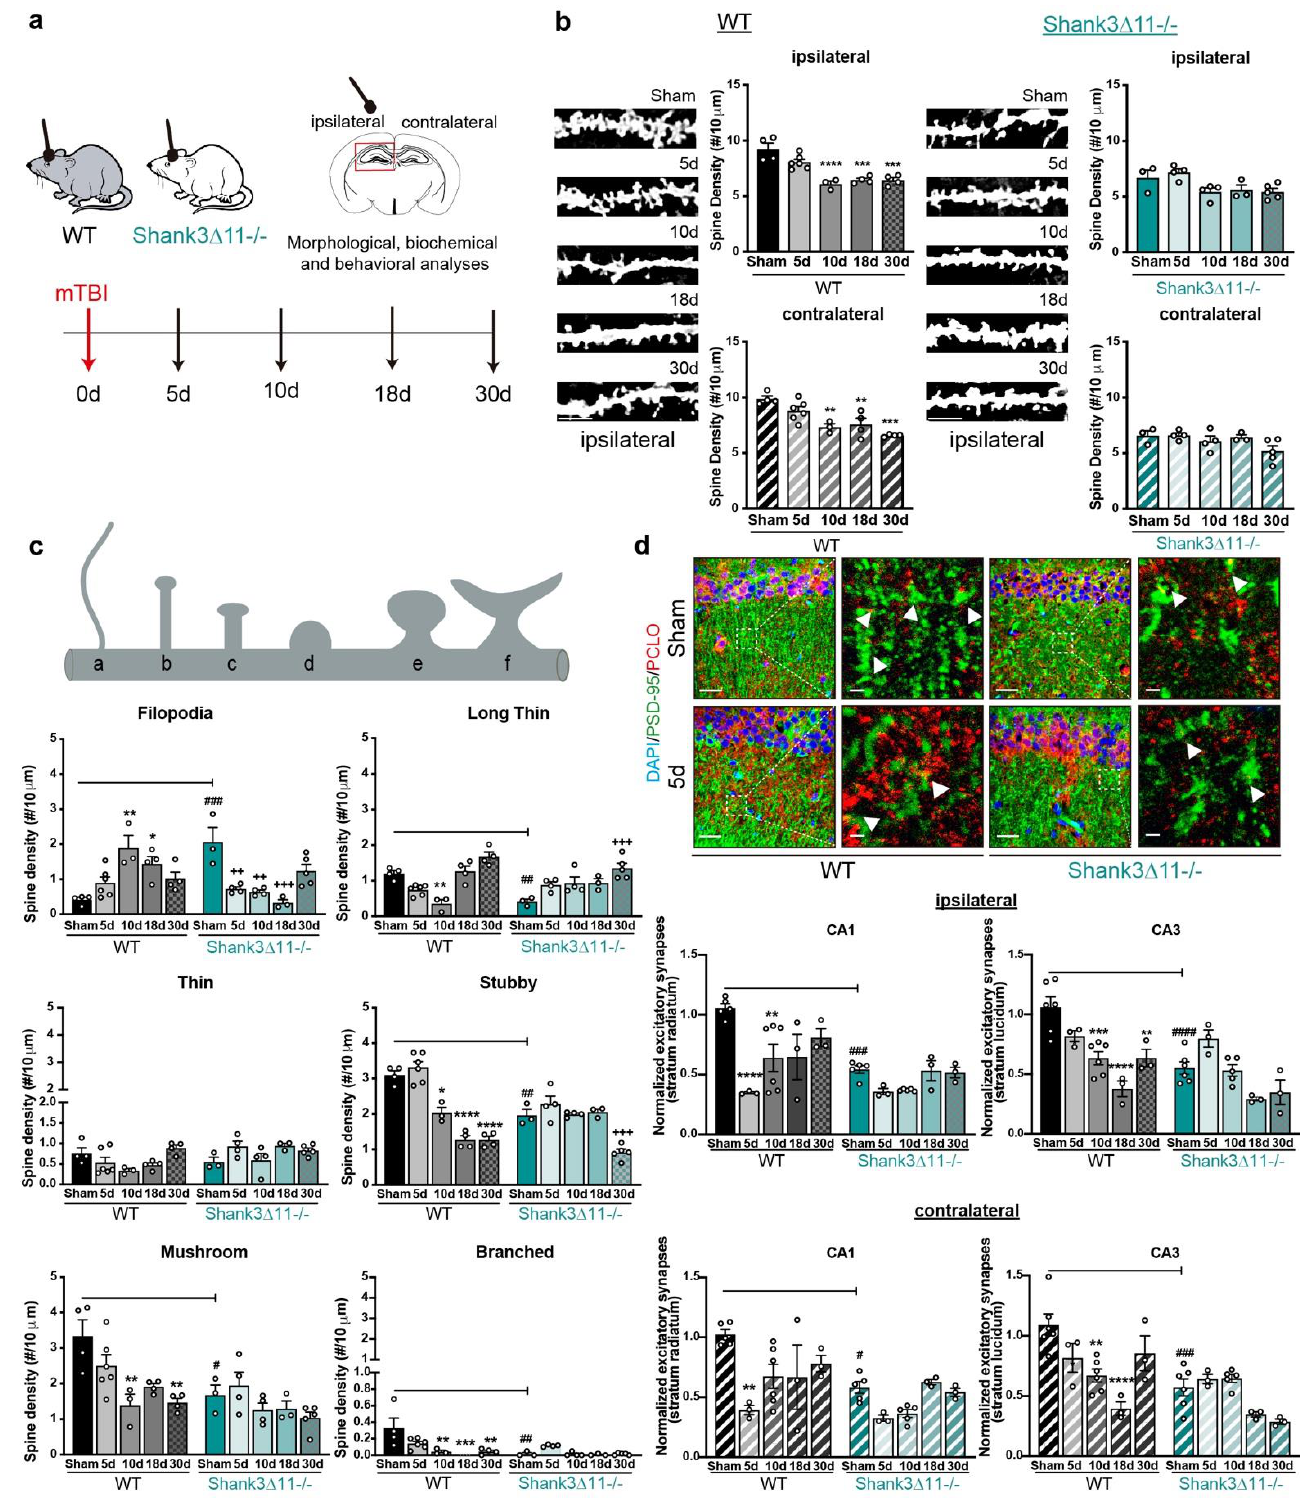
Figure 1. Wild-type mice but not Shank3 -deficient animals exhibit a loss of excitatory synapses after mTBI. ( a ) Schematic representation of the experimental design of this study. ( b ) Analysis of the dendritic spine density in the CA1 hippocampus after Golgi staining. The number of spines was analyzed on the ipsilateral (filled bar) and contralateral (hatched bar) sides in WT (black bars, left panel) and Shank3 ∆ 11 − / − animals (turquoise bars, right panel) after mTBI (scale bar, 5 µ m). N = 3–6, error bars represent mean ± SEM; one-way ANOVA with Bonferroni’s post hoc comparison test was performed [WT ipsilateral side: F(4, 16) = 17.37, p = 0.0001; contralateral side: F(4, 16) = 11.63, p =